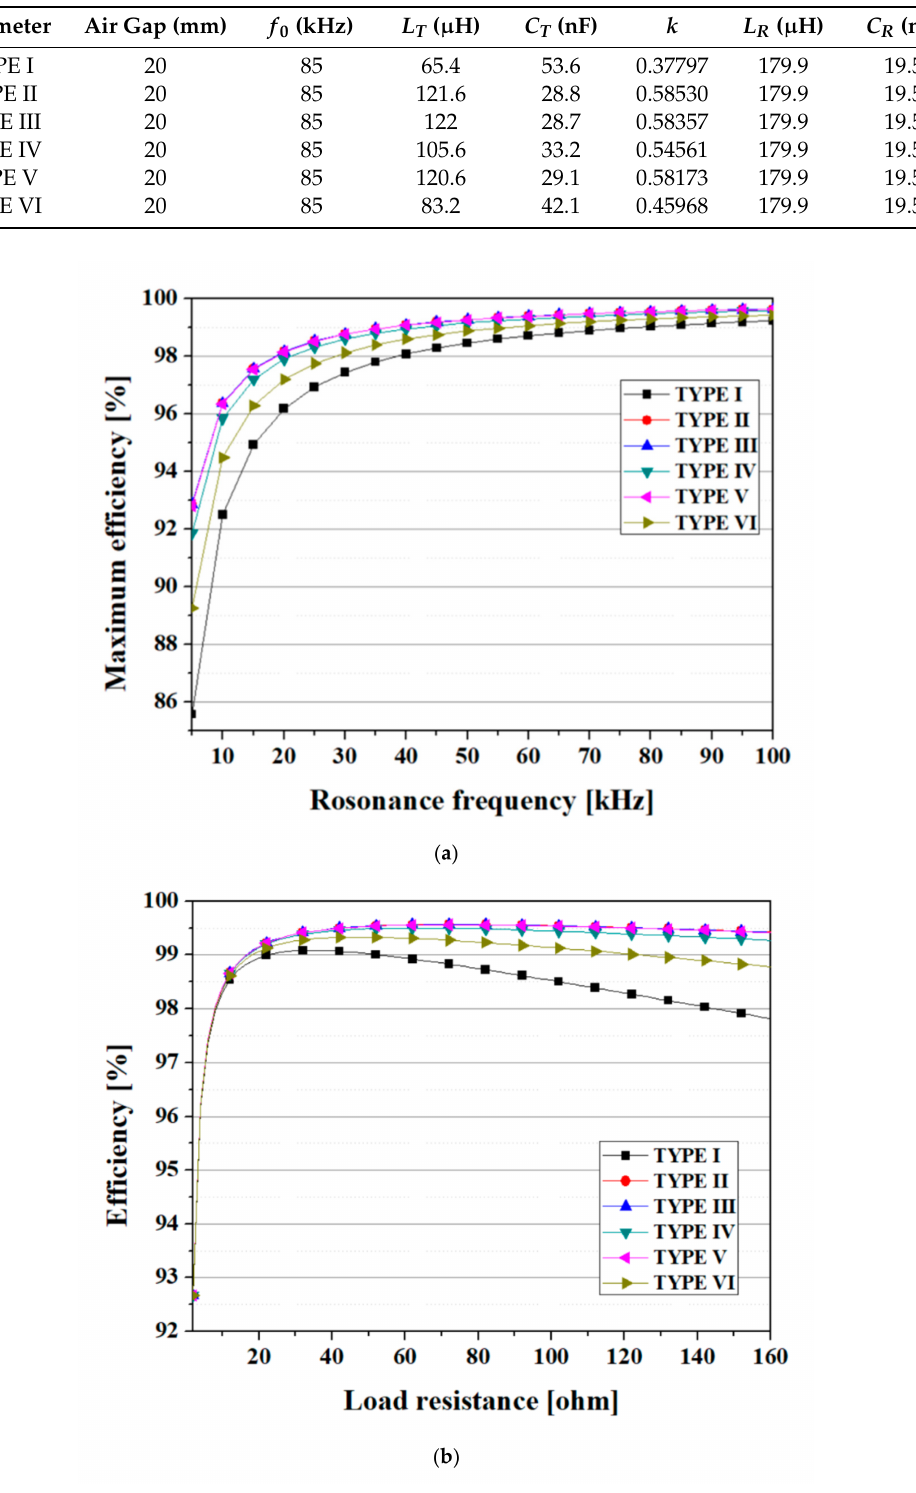
Figure 10. Power transfer e ffi ciency characteristics: ( a ) maximum e ffi ciency according to the resonance frequency and ( b ) e ffi ciency according to the load